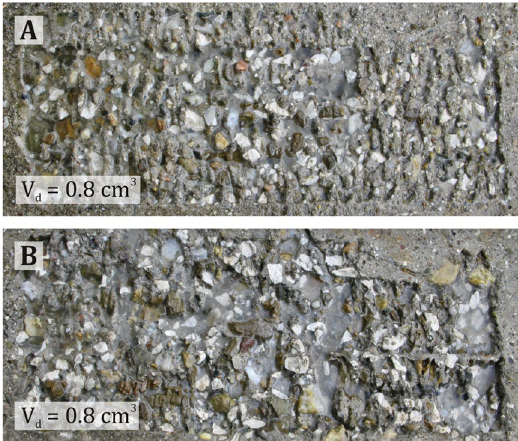
Fig. 1. Comparison of surfaces treated by pulsating oscillating jet (A) with those treated – disintegrated volume, water by continuous oscillating jet (B) on concrete road panel (V d pressures: 70 MPa (A), 200 MPa (B), nozzle diameters: 1.2 mm (A), 0.81 mm (B), stand-off distances: 50 mm (A), 45 mm (B), material removal rate of area treatment: 12 cm 2 s –1